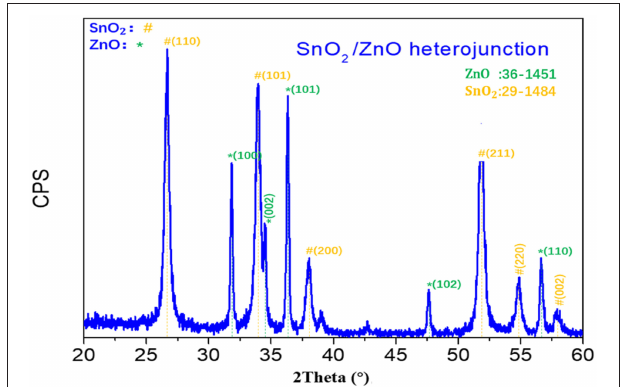
FIGURE 1 | XRD patterns of the SnO 2 /ZnO composite heterojunction material.